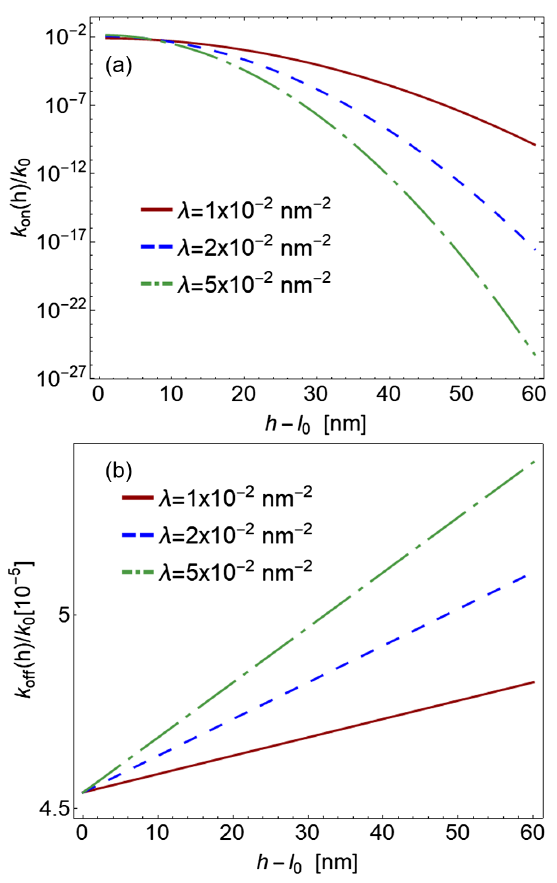
FIG. 4. Bell-like rates as a function of the distance between the ligand and the receptor for three different values of re- ð h Þ , given by Eq. (10) ceptor stiffness λ . (a) Binding rate k on ð h Þ given by Eq. (11). The width of the (b) Unbinding rate k off binding pocket is taken to be α ¼ 0 . 2 nm in both figures. The intrinsic binding affinity (depth of the potential well) is set to ϵ ¼ 10 ð k T Þ , as typical binding energies are within this range, b B T for E-cadherin interactions [61] and 35 k T for the e.g., 2 k B B biotin-streptavidin, which is the strongest bond found in nature [56]. Values for the receptor spring constants λ were motivated by prior work [62]. The intrinsic rate k 0 serves as an unspecified unit for the